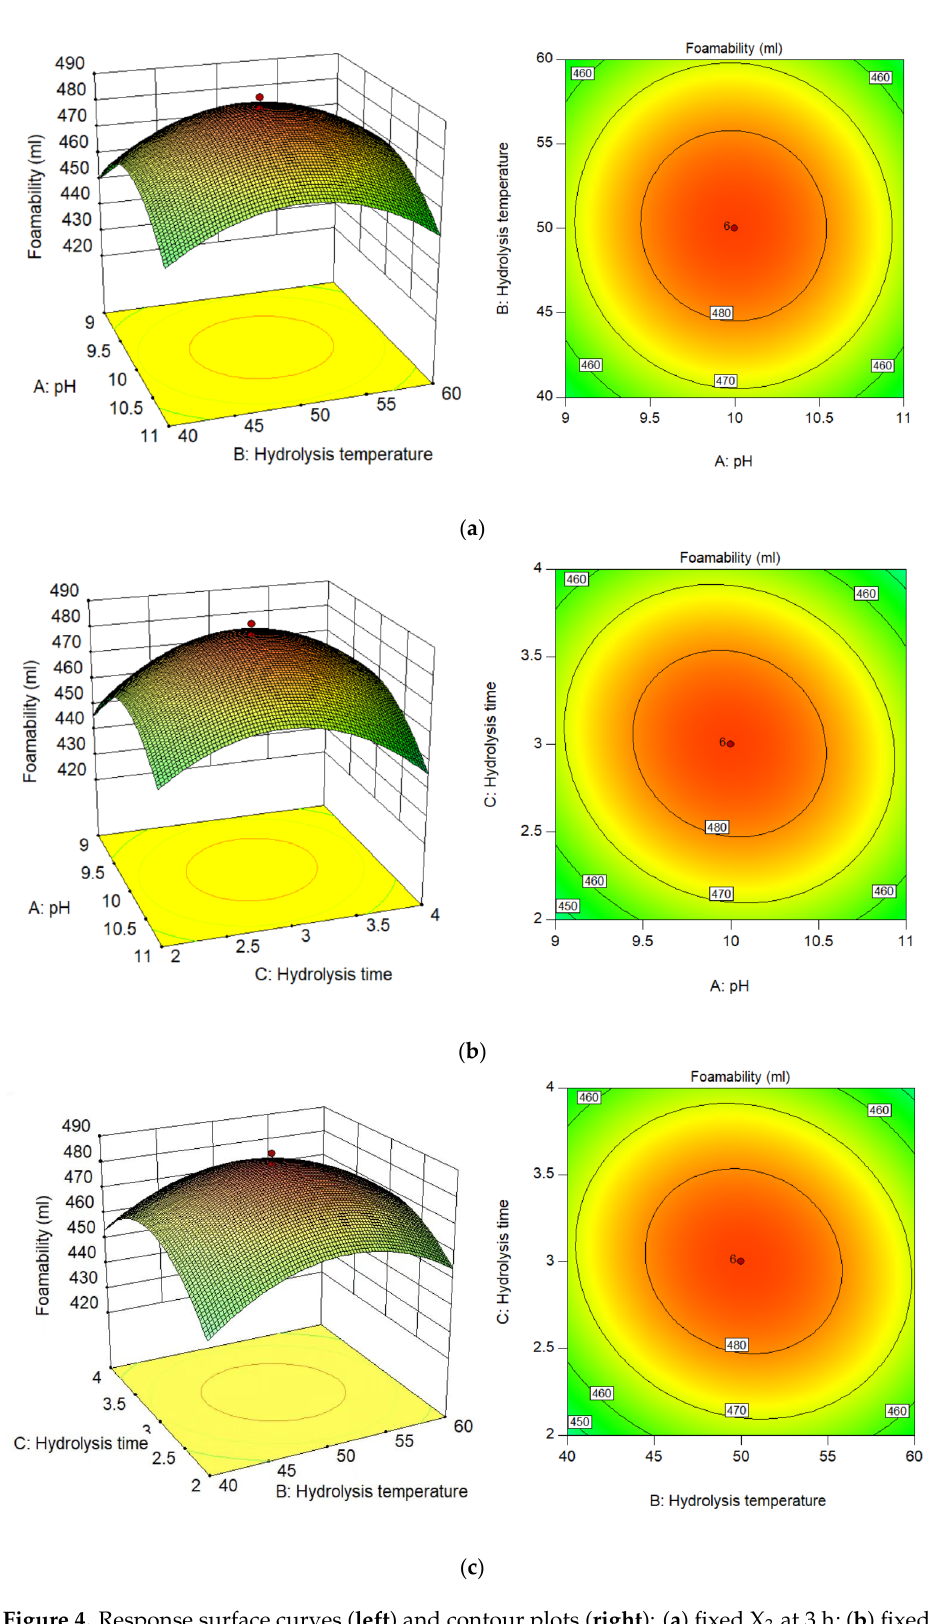
Figure 4. Response surface curves ( left ) and contour plots ( right ): ( a ) fixed X 3 at 3 h; ( b ) fixed X 2 at 50 ◦ C; ( c ) fixed X 1 at